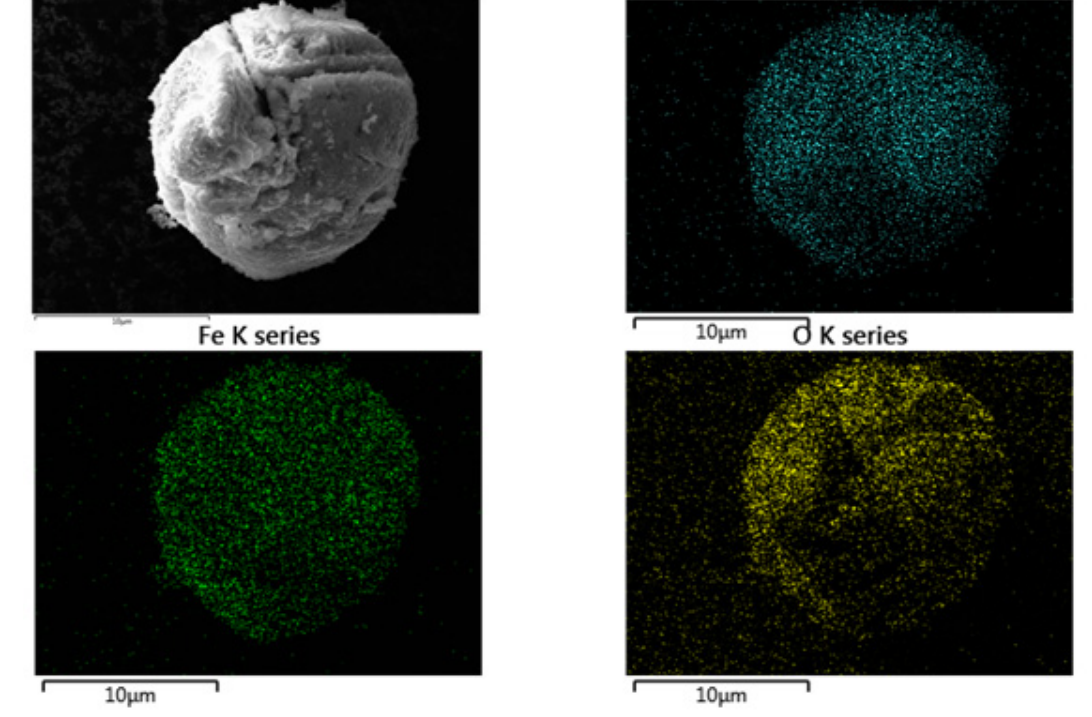
Figure 2. EDX elemental mapping showing the spatial distribution of Ag, Fe and O elements on the surface of the Ag@ α -Fe 2 O 3 nanocomposite agglomerate showed in the SEM image.